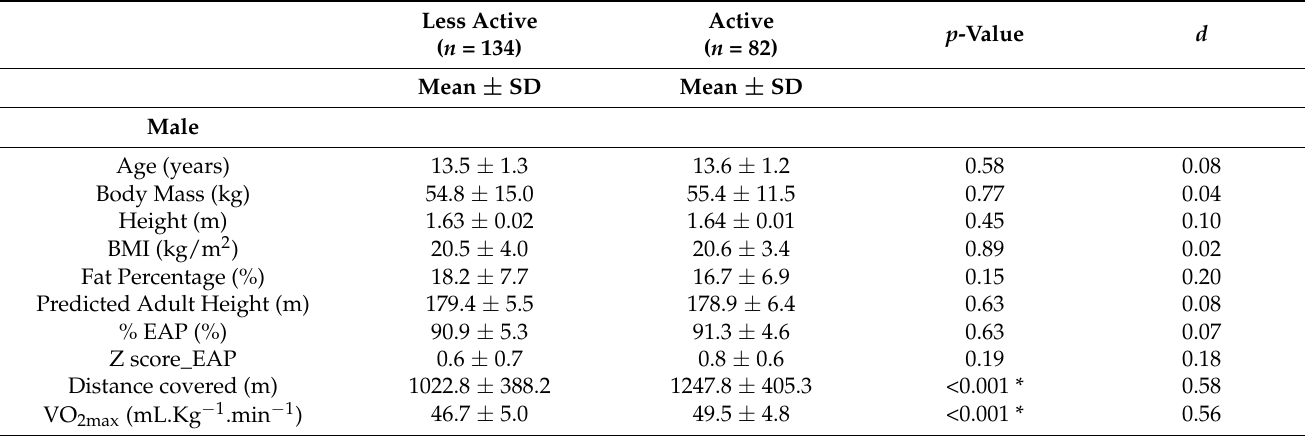
Table 1. Descriptive characteristics of the sample of students in relation to the study